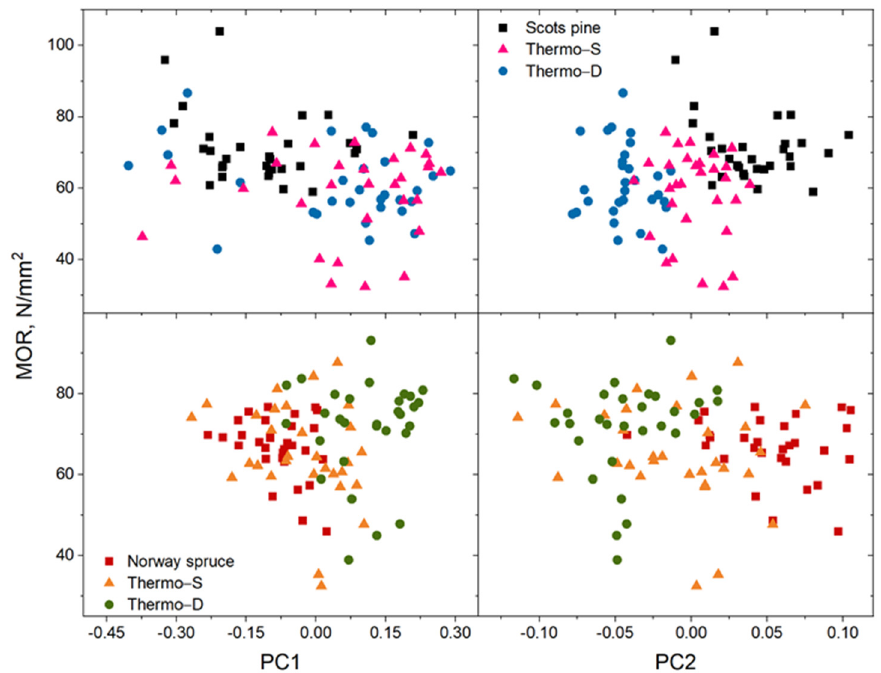
Figure 8. MOR plotted as a function of PC1 and PC2 scores for untreated and Thermo-Wood ® Norway spruce and Scots pine.